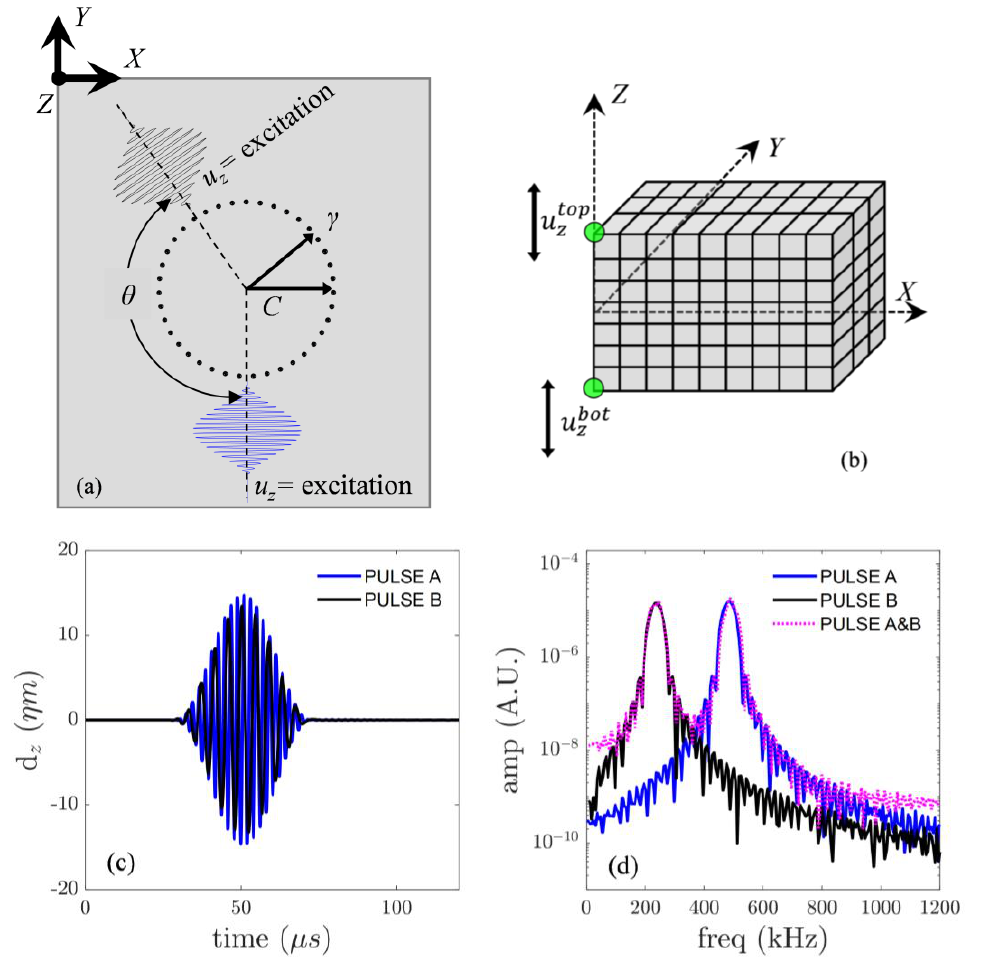
Figure 2. ( a ) Schematic diagram of the non-collinear FE model, ( b ) top and bottom nodal displace- ments, ( c ) time-domain, and ( d ) frequency spectra of out-of-plane displacement of incident waves at point C .